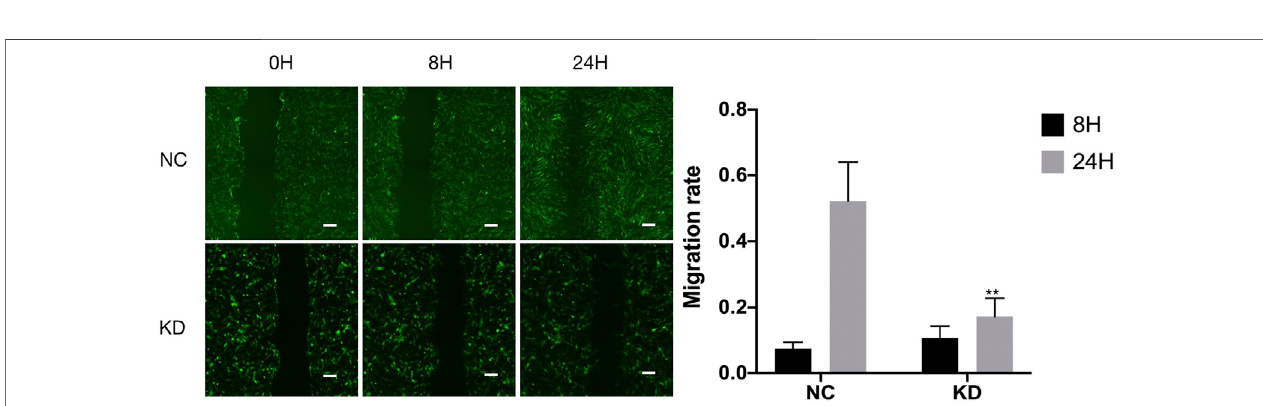
FIGURE 14| Wound-healing assay on hsa_circ_0005505 silenced HBVSMCs and negative control. The graph shows quanti fi cation ofthe residual wounded area 0, 8, and 24 h after scratch. Scale bar (cid:1) 100 μ m. KD (cid:1) knockdown of hsa_circ_0005505, NC (cid:1) negative control. * p < 0.05, ** p < 0.01, *** p < 0.001.